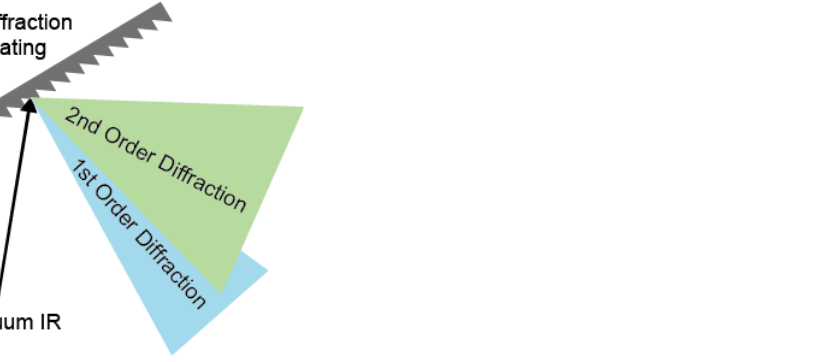
Figure 2. Schematic representation of the diffraction grating for spectral analysis of continuum IR beam. Figure 3. ( a ) Transmittance spectrum of 2.4 μm IR long - pass filter (black) and 4.5 μm IR long -pass filter (red). ( b ) Continuum IR spectra obtained with 2.4 μm IR long - pass filter (black) and 4.5 μm IR long-pass filter (red). ( c ) Corrected continuum IR pulse spectrum, where the spectrum under and over 4.5 μm are obtained with 4.5 μm and 2.4 IR long -pass filter, respectively.